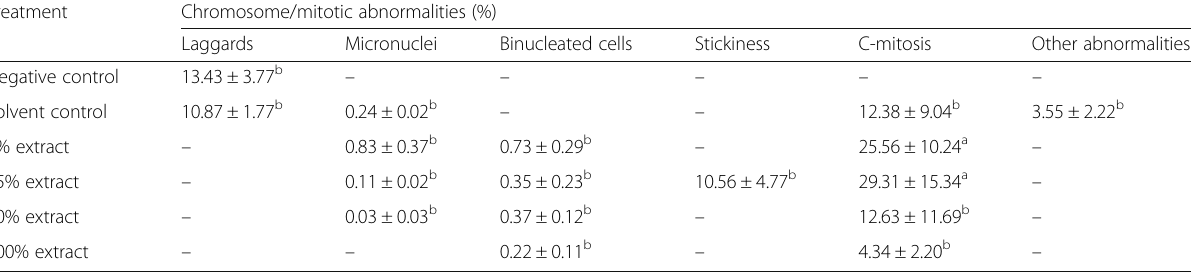
Table 6 Types and frequencies of chromosome aberrations and mitotic abnormalities induced by the hydro-alcoholic extracts of Juniperus communis L *